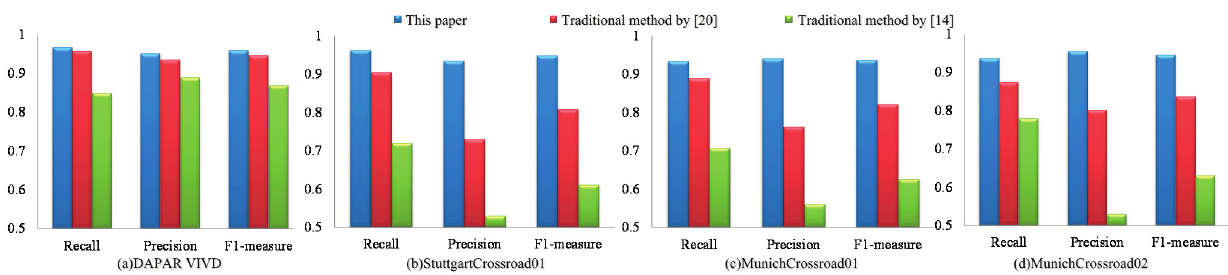
Figure 7. The statistical result of our method and the traditional methods by